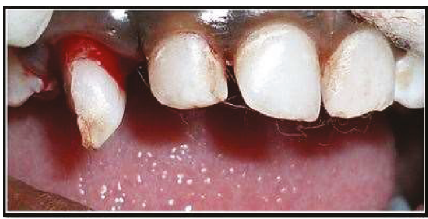
Figure 3: Surgically extruded